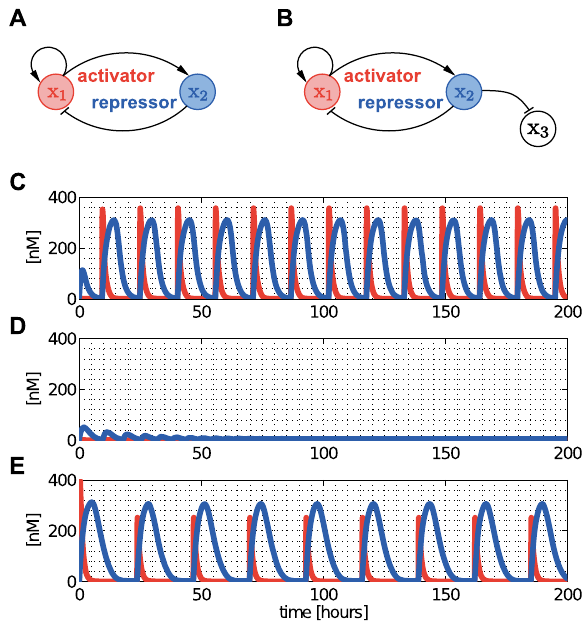
Figure 6. Neglecting internal retroactivity could falsely predict that the activator-repressor clock will display sustained oscillations. (A) The module consists of the activator protein x 1 (dimer) and the repressor protein x 2 (tetramer), with dissociation constants k 1 and k 2 , respectively. (B) An extra node x 3 is introduced as a target for the repressor. (C) Without accounting for internal retroactivity, the module in A exhibits sustained oscillations. (D) When internal retroactivity is included for the module in A, however, the equilibrium point is stabilized and the limit cycle disappears. (E) Oscillations can be restored by applying a load on the repressor (module in B) with concentration g , so that the repressor dynamics are slowed down. Simulation parameters: p 1,0 ~ 0 : 04hr { 1 , p 1,1 ~ 2500hr { 1